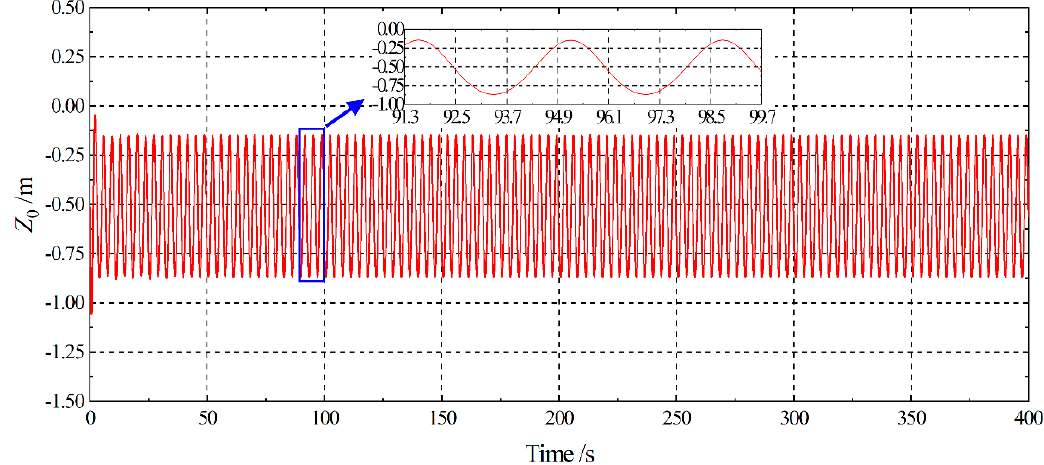
Figure 10. Time history of heave of the towing ship.